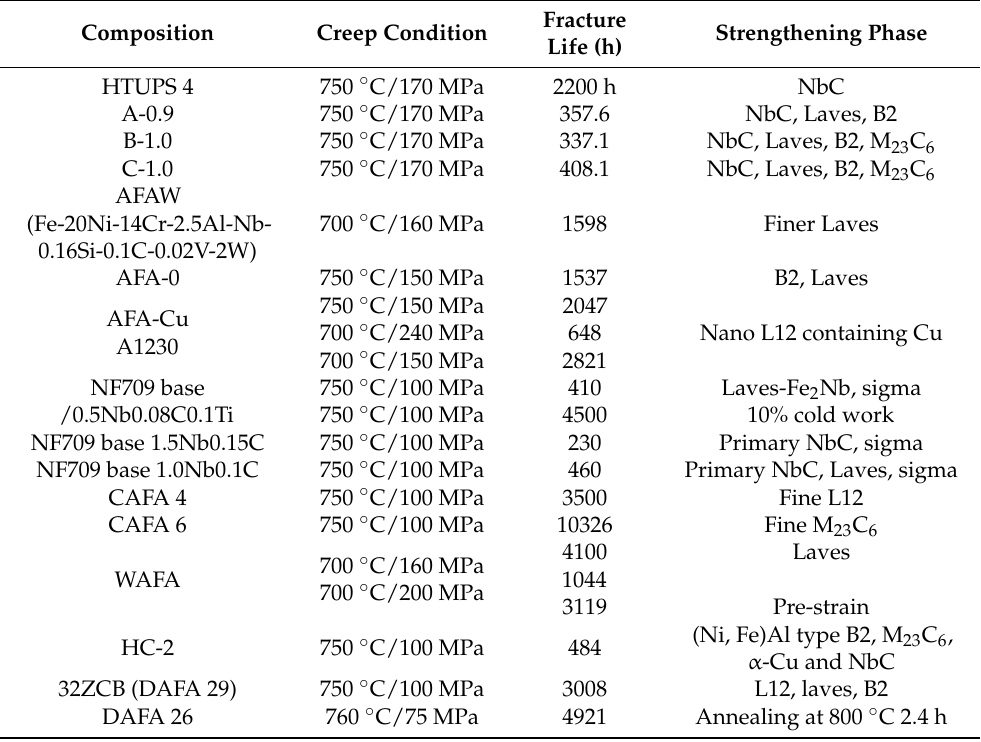
Table 5. The creep properties of AFA steels.